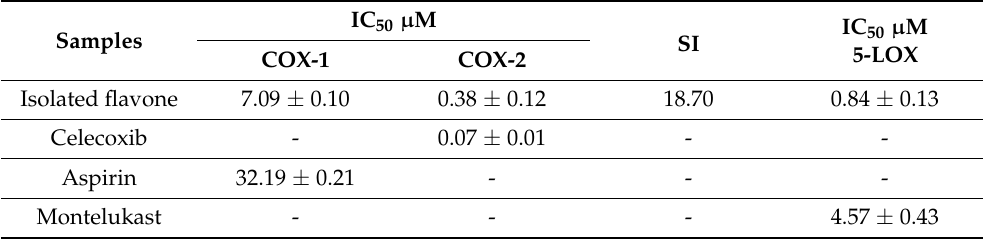
Table 2. Percent COX-1/COX-2 and 5-LOX inhibition activity of isolated